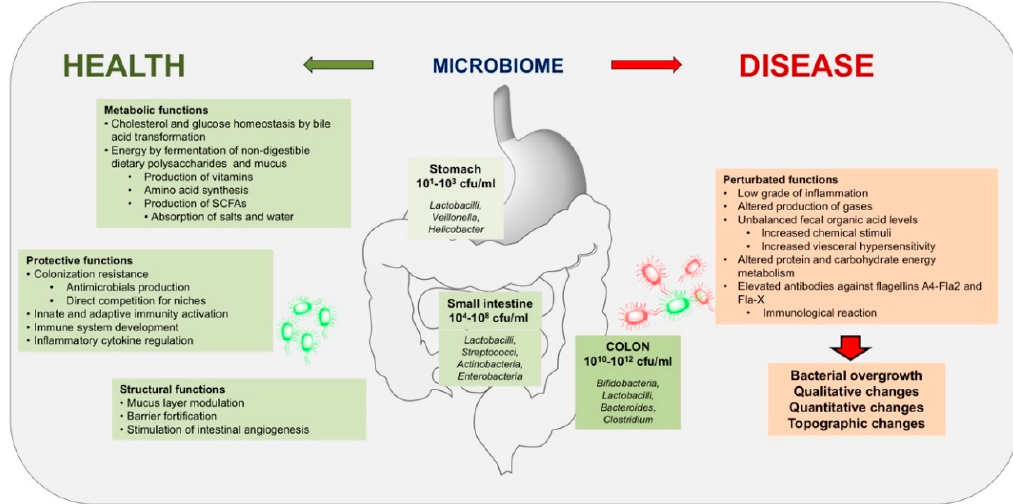
Figure 6. Distribution and function of microbiota in human intestine during health or disease. The bacterial community is the core component of microbiota in the gastrointestinal tract and there are eukaryotic microbes. In healthy subjects, microbial density and types vary across the gastrointestinal tract, with density increasing dramatically in oro-aboral direction. Microbial composition also changes. The crosstalk between bacteria and host contribute to maintain physiological metabolic, protective, and structural functions. In disease, shift of relative abundance in microbial species or quantitative variations of microbiota occur, generating chronic low-grade inflammation, atypical gases and fecal levels of organic acids, impaired metabolism of proteins and carbohydrates and immunological responses [2,102–106].